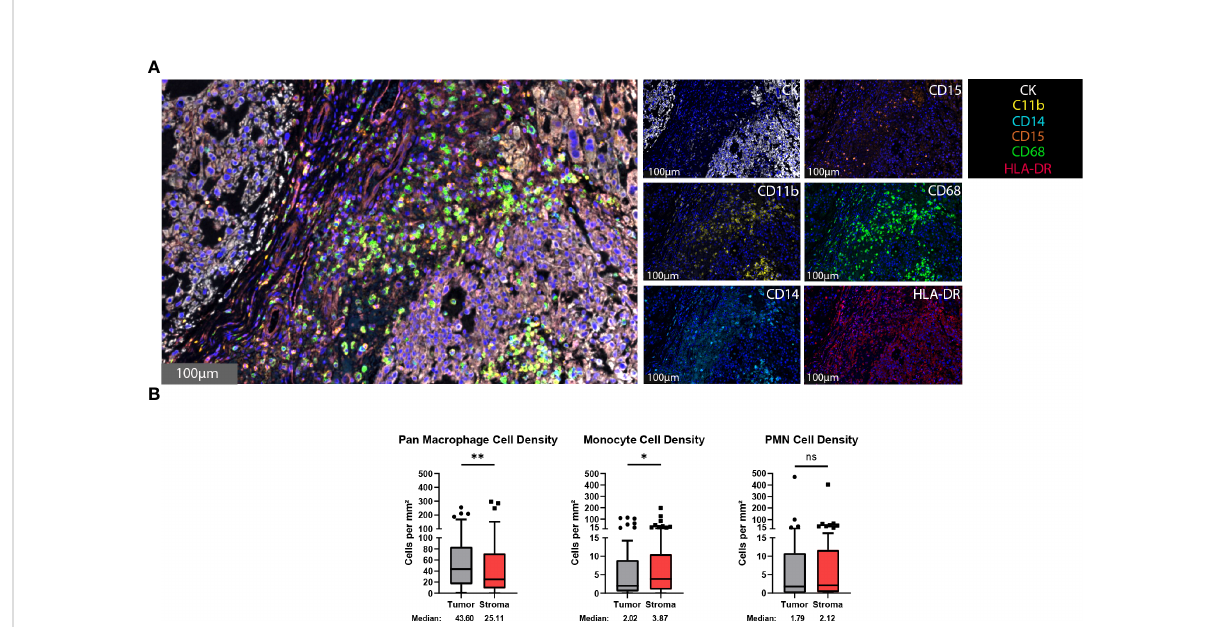
FIGURE 1 Myeloid cells are found within the chordoma tumor immune microenvironment. (A) Representative photomicrographs from one chordoma of merged and single-color immuno fl uorescence images assessing the presence of myeloid cells with a validated panel of six biomarkers, CD11b (yellow, Opal 570), HLA-DR (red, Opal 690), CD14 (turquoise, Opal 480), CD15 (orange, Opal 620), CD68 (green, Opal 520), and CK (white, Opal 780). Multispectral immuno fl uorescence images are counterstained with DAPI. High expression of CD68 identi fi ed pan macrophages. Co- localization of CD11b and CD14 without CD15 and HLA-DR identi fi ed monocytes. Co-localization of CD11b and CD15 without CD14 and HLA- DR identi fi ed PMNs. Expression of CK identi fi ed chordoma tumor cells. (B) Quanti fi cation of pan macrophages, monocytes, and PMNs per mm 2 in chordoma tumor and stroma (n = 56 individual tumors). Wilcoxon signed rank tests with p value threshold of <0.05 were used to compare tumor and stroma myeloid cell in fi ltrate. * p ≤ 0.05, ** p ≤ 0.01, ns, non signi fi cant. CK, cytokeratin; DAPI, 4 ′ ,6-diamidino-2- phenylindole; PMN, polymorphonuclear